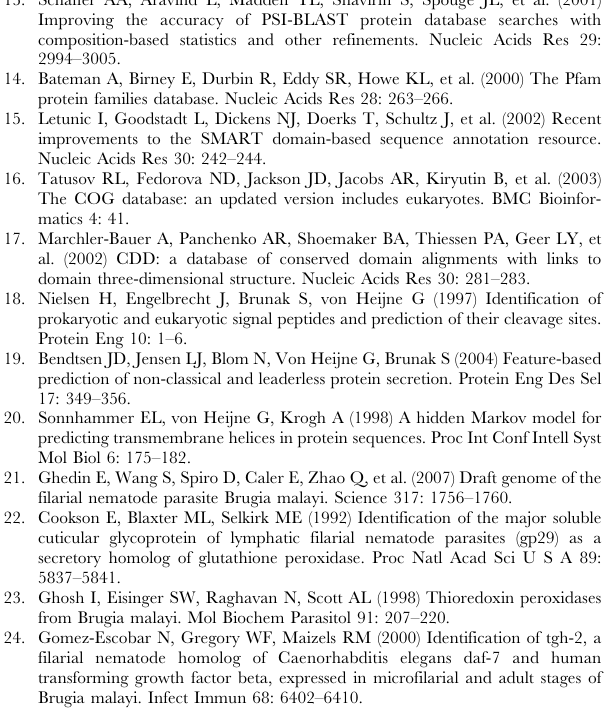
Table S1 Annotated secretome. Proteins identified in the ES of Brugia malayi are listed as spectral values (abundance / number of peptides identified per protein). The Pub-Locus is a stable gene ID. Reference ID is the TIGR reference gene ID, AMES is the adult male ES, AFES is the adult female ES, MFES is the microfilarial ES, L3-ES is the L3 larval ES, L3-MES is the molting L3 ES. * denotes that the peptides identified are non-unique (highlighted in yellow), but mapped to a protein family e.g. Thioredoxins.; N # Y followed by a number denotes the Y-number of non-unique peptides (highlighted in light green) identified for that particular protein with N-number of unique peptides identified. A fully annotated secretome is given in Final Secretome-Web (http:// exon.niaid.nih.gov/transcriptome/Bm-secretome/Brugia-Secretome- Web.zip) Table S2 AMES Peptide List. The table describes the peptides identified and the corresponding protein in the ES of adult male Brugia malayi . NTPS - Number of times peptide seen; NSH - Non- specific hits (Peptides matching with more than one protein; the number denotes number of proteins that the peptide has matched hits by BLASTP). Non-specific peptides are highlighted in yellow. Table S3 AFES Peptide List The table describes the peptides identified and the corresponding protein in the ES of adult female Brugia malayi . NTPS - Number of times peptide seen; NSH - Non- specific hits (Peptides matching with more than one protein; the number denotes number of proteins that the peptide has matched hits by BLASTP). Non-specific peptides are highlighted in yellow. Table S4 MFES Peptide List. The table describes the peptides identified and the corresponding protein in the ES of microfilariae of Brugia malayi . NTPS - Number of times peptide seen; NSH - Non-specific hits (Peptides matching with more than one protein;